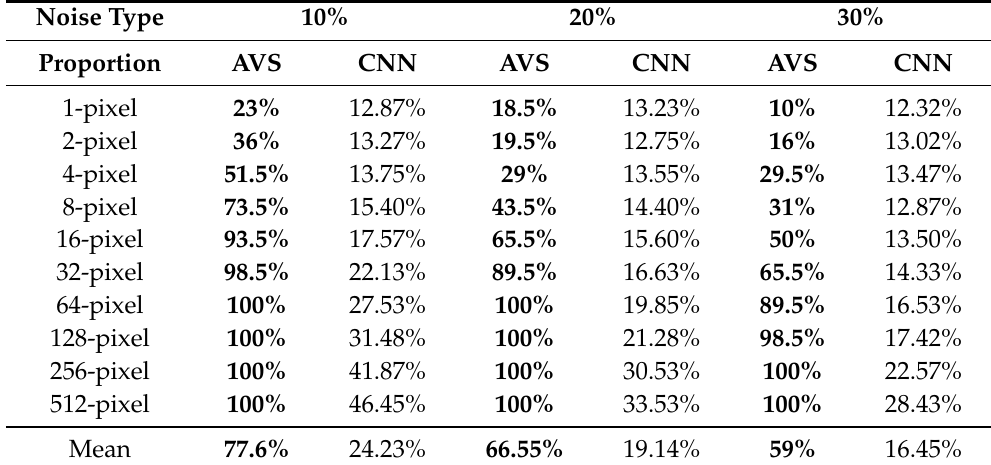
Table 6. The experimtental results of AVS and CNN under the dynamic full-image